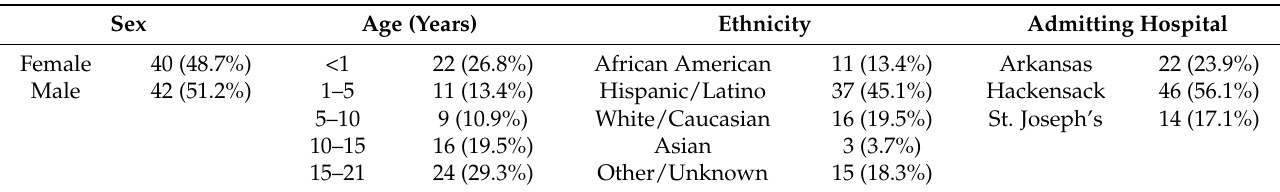
Table 1. Sex, Age, Ethnicity, and Admitting Hospital for Subjects (N = 82).